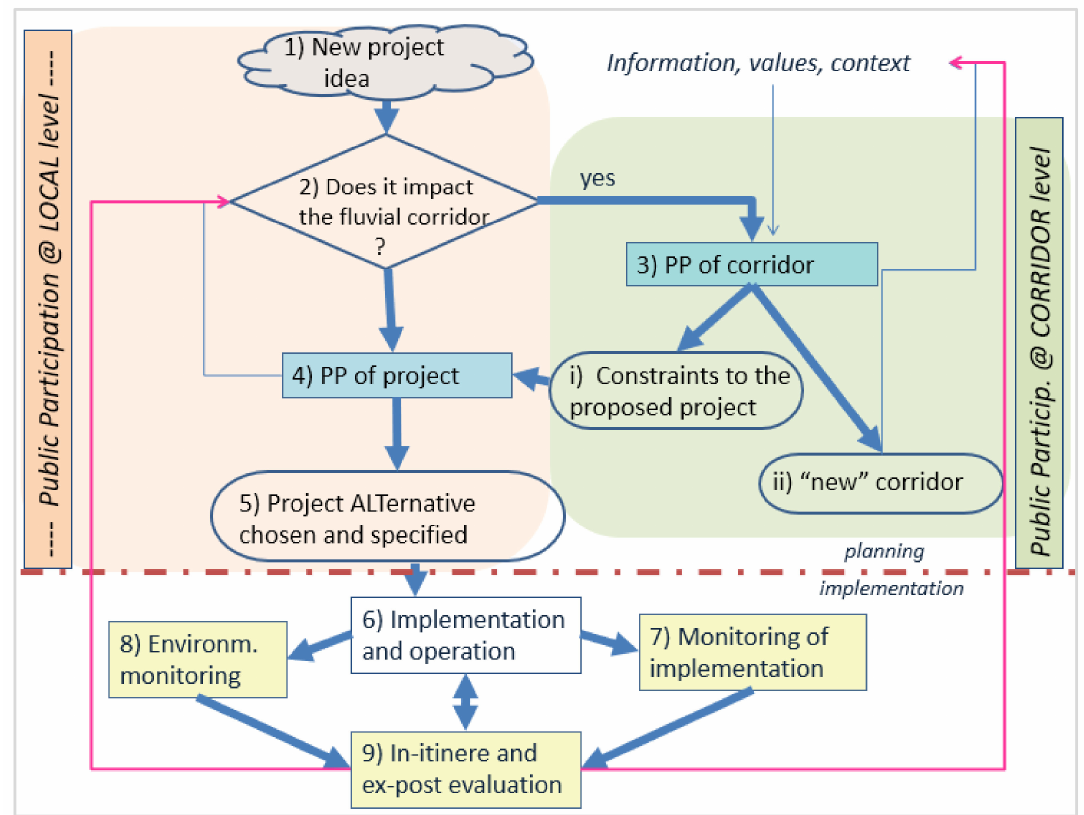
Figure 12. Algorithm for adaptive Participatory Planning Process (PP) for the definition and adaptive management of a fluvial corridor (the fluvial space) at the planning level (above) and at the implementation level (below). We assume that the fluvial space has been set, so defining a river “corridor” (stressing that this includes not only the active channels themselves, but also a portion of the floodplain with its geomorphological units and its system of exploitation and control works). At a certain point in time, a new project may come into play which aims at river restoration (e.g., re-meandering), or at river exploitation (e.g., a hydropower plant), or management (e.g., sediment re-distribution), or simply for any other purpose that may have some impact on the river (e.g., a road). The scheme envisages a PP at the “local” scale (i.e., of the Project itself), and at the “corridor” scale, depending on the impact level of the proposed new project. A decision is first issued on which level to address, based on an extended Environmental Impact Assessment that includes all relevant objectives, including economics. At the local level, the PP will not change the fluvial space, but may change the project (e.g., through suitable mitigation or compensation measures or even rejection); at the corridor level, the PP might end with a modification of the fluvial space previously established and, typically, with constraints to be fulfilled by the project. Environmental and implementation monitoring are essential components both during planning and implementation (“in itinere”) and afterwards (“ex